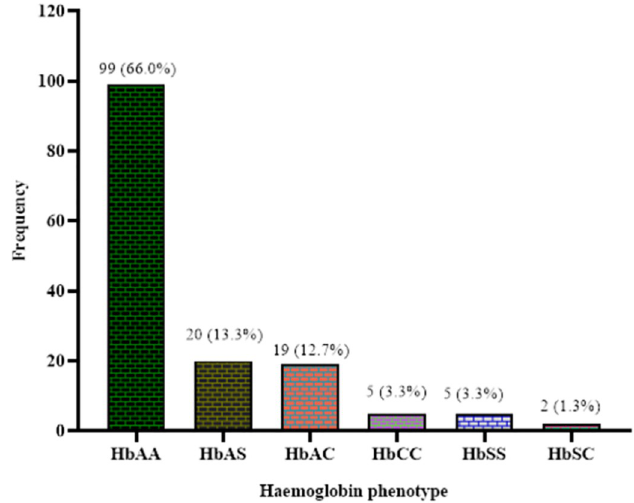
Fig 1. Distribution of haemoglobin phenotypes among the study participants.